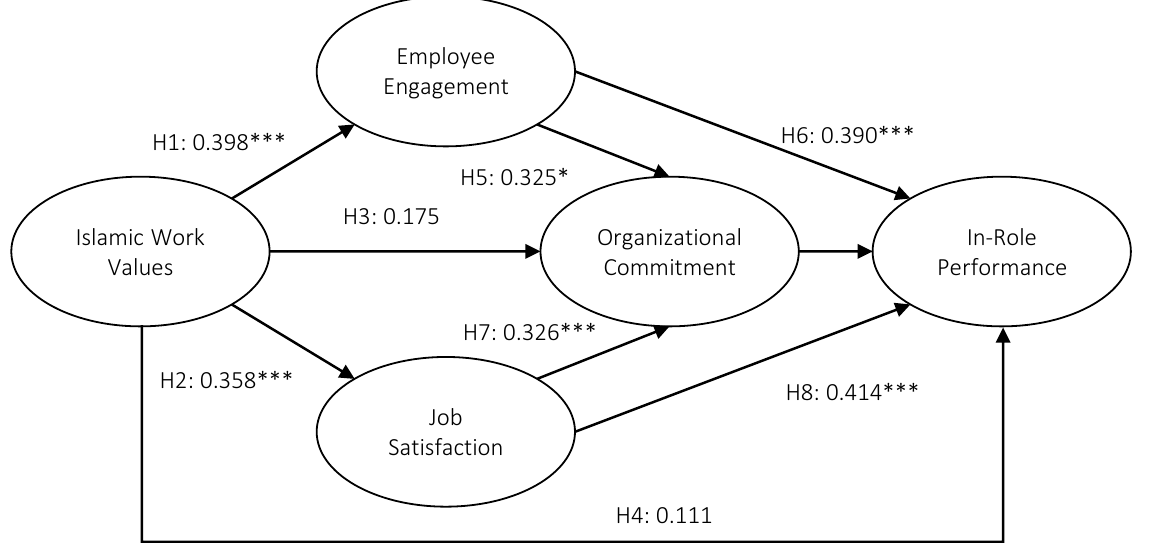
Figure 2. PLS-SEM analysis result